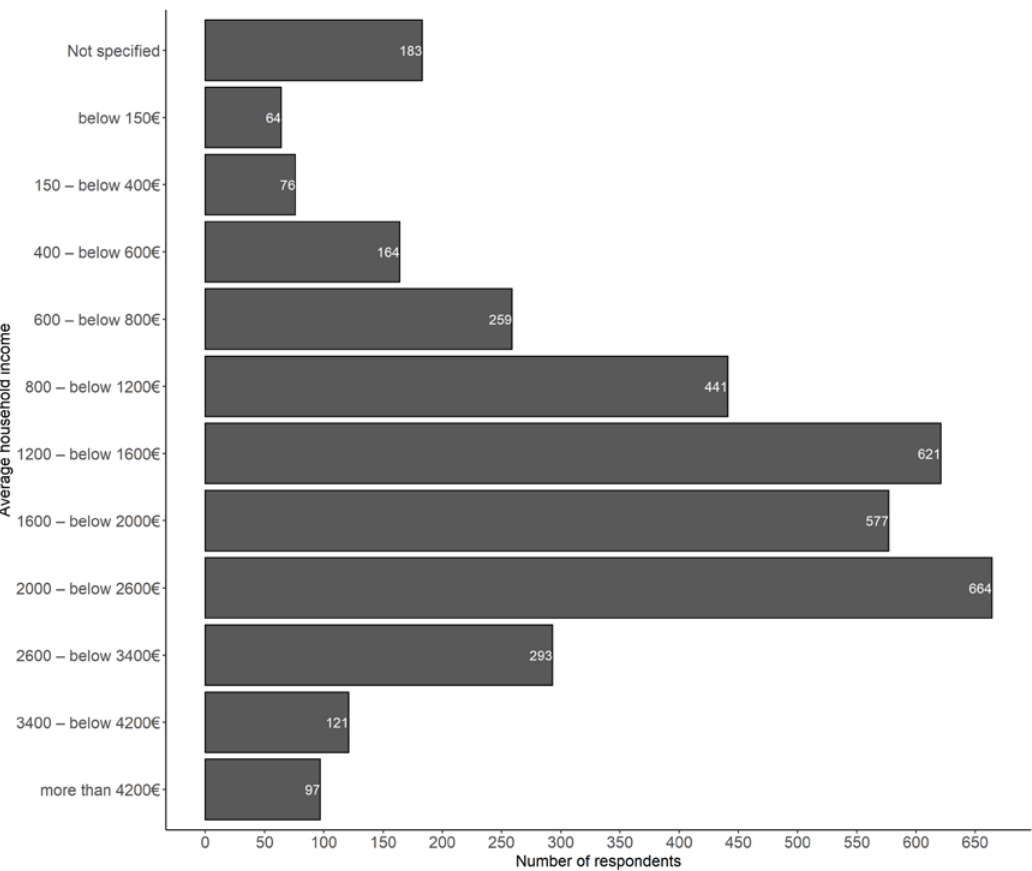
Figure A3.1: Average net income of survey respondents